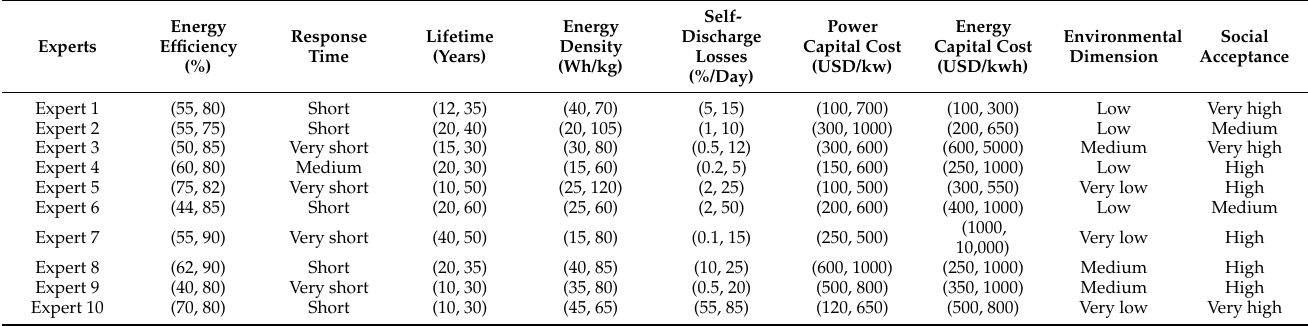
Table A21. The expert’s evaluation information in Scenario 1.